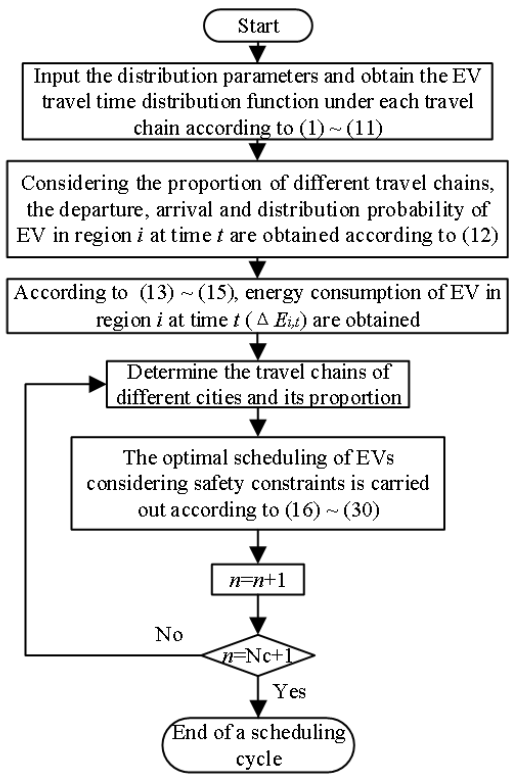
Figure 3. Flow chart of the scheduling strategy.